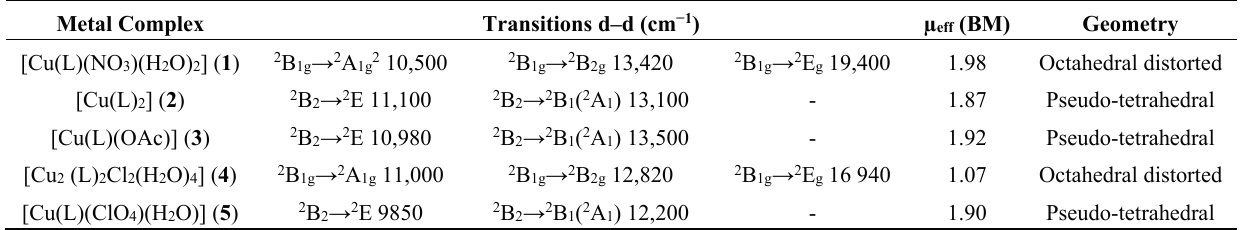
Table 3. Electronic spectra (cm − 1 ) and magnetic moments (BM) of the complexes 1 – 5 . Metal